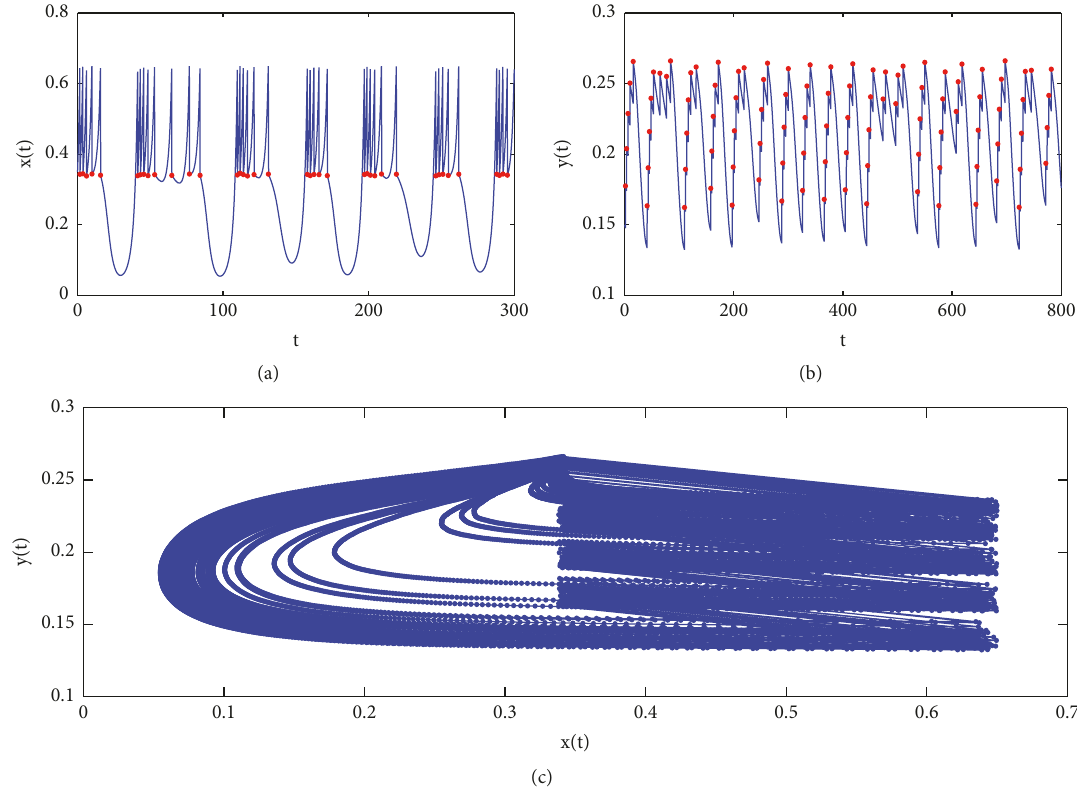
Figure 5: Solutions of model (47), parameters are fixed as 𝑟 = 1, 𝐾 = 2, 𝑎 = 0.188, 𝜇 = 0.035, 𝐷 = 0.05,𝐸𝑇 = 0.65,𝜃 = 0.48, 𝜏 = 0.03, 𝛼 1 = 0.01,𝛼 = 0.005 2